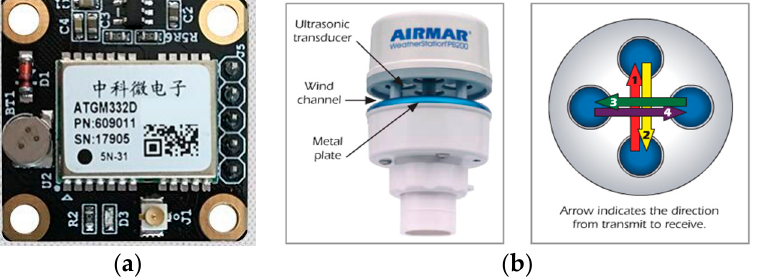
Figure 12. Sensor Equipment: ( a ) GPS; ( b ) ultrasonic transducer.